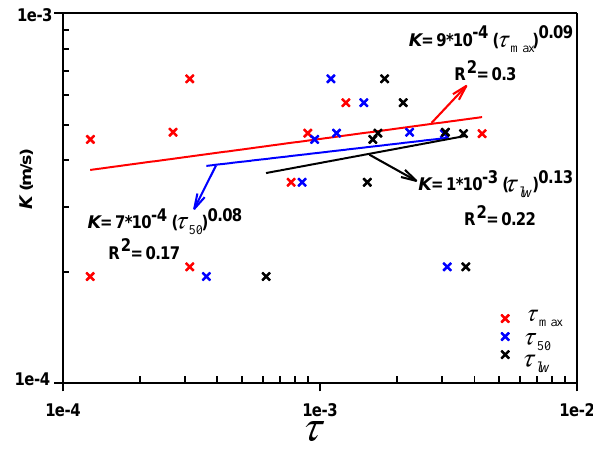
Fig. 13. Log-log plot of the maximum relaxation time ( max ), median relaxation time ( 50 ) and 286 Fig. 13. Log–log plot of the maximum relaxation time ( τ max ), me- weighted average relaxation time ( lw ) against the measured hydraulic conductivity ( K ) of nine 287 dian relaxation time ( τ 50 ) and weighted average relaxation time core samples from the 1 st aquifer (see Fig. 1). 288 ( τ lw ) against the measured K of nine core samples from the first aquifer (see Fig. 1).